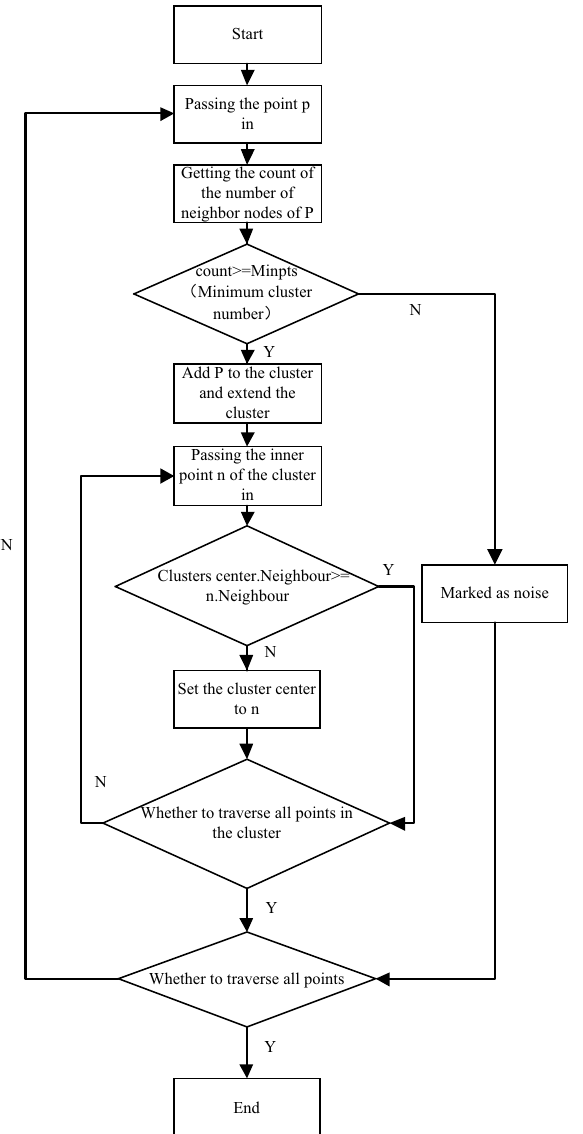
Figure 4. The cluster center identification